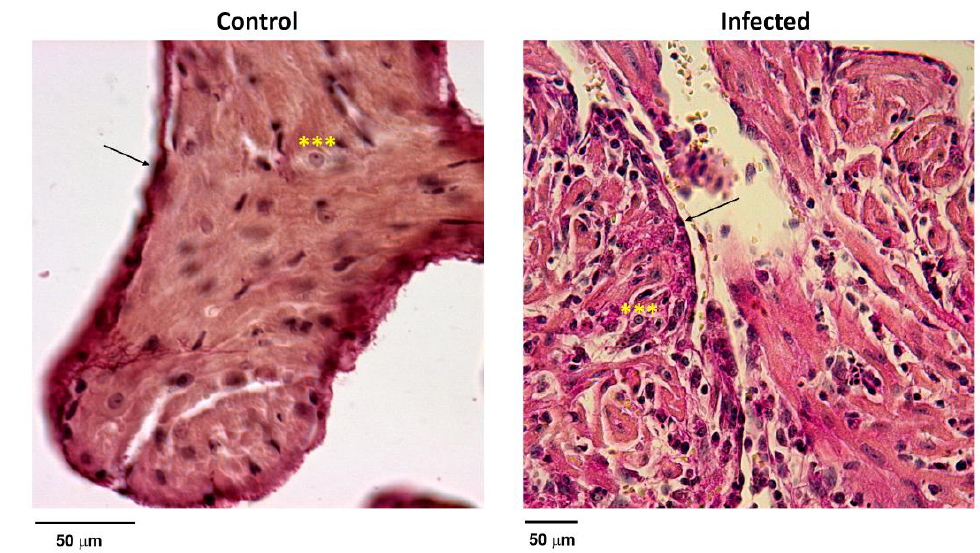
Figure 4. Histological sections of auricles stained with Van Gieson’s stain. The left panel shows the normal morphology of cells compatible with pyramidal P cells (***) and peripheral fusiform fibroblast-like cells (arrow) located externally to the nodal area. Structural relationships are well-defined and conserved. The right panel shows the right auricle of the infected tissue with loss of structure and depopulation of pyramidal cells. A moderate mononuclear infiltrate can be appreciated. Fusiform fibroblast-like cells preserve morphology and location (arrow).